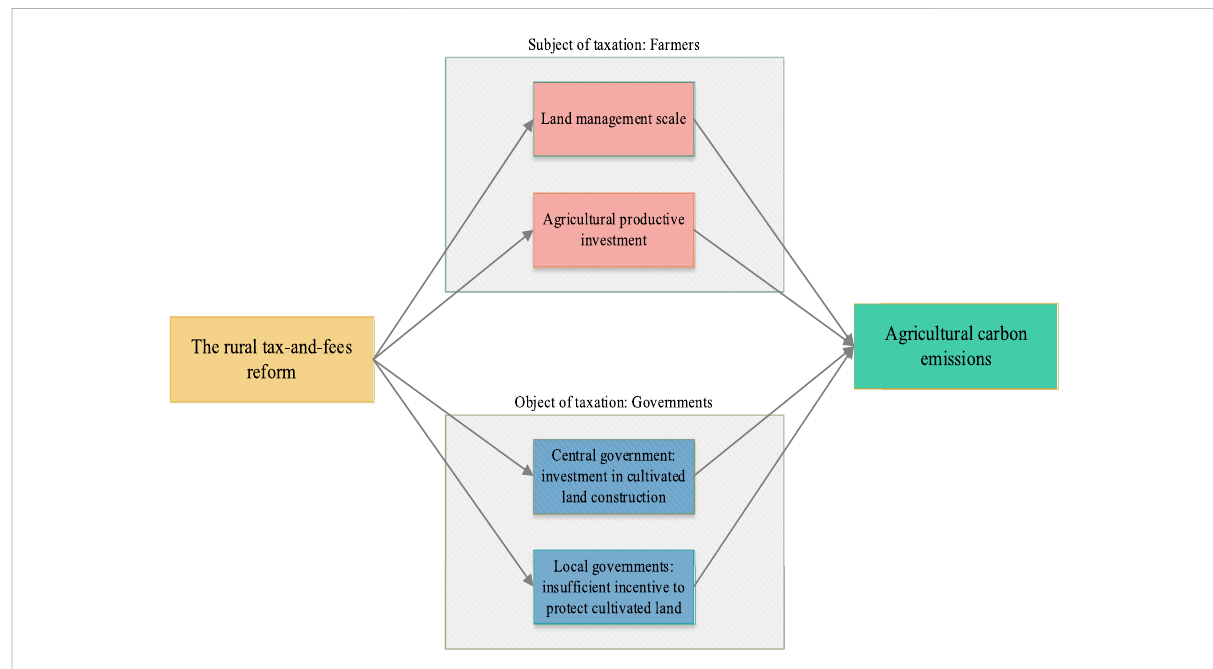
FIGURE 1 Framework for analyzing the agricultural carbon abatement effect of the RTFR in